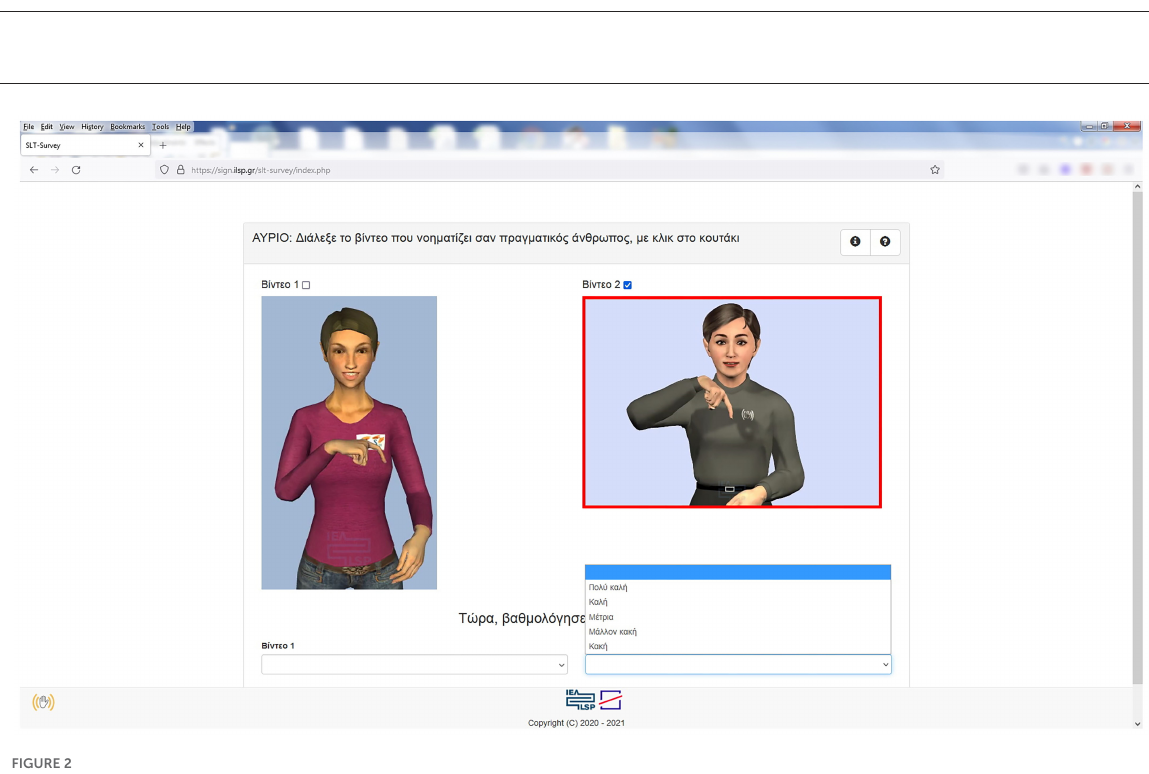
FIGURE1 Head-to-head inspection regarding the expression of sorrow (Paula on the left, Françoise on the right), red color code indicating viewer preference, yellow color code indicating obligatory ranking of both avatars before moving to the next page.